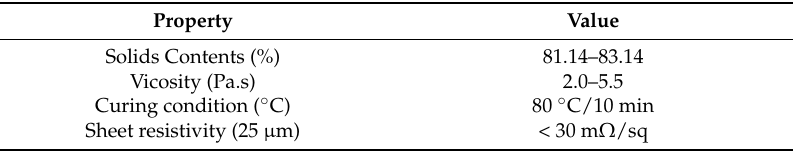
Table 1. C2130429D3 ink’s parameters.